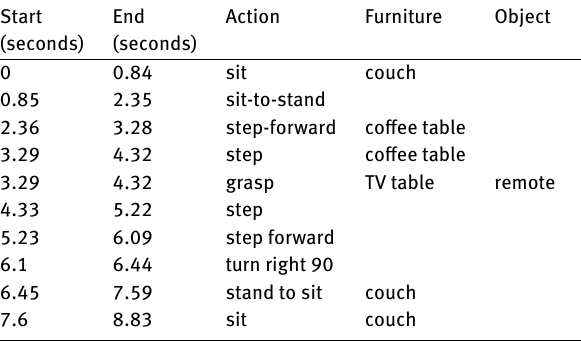
Table 3: The pick the remote scenario: ground truth